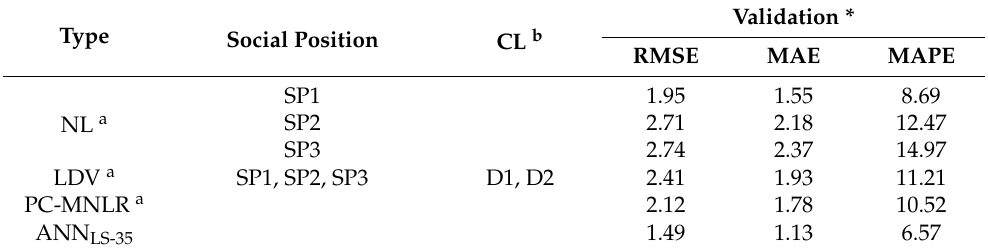
Table 5. Performance of different techniques to estimate the height of Brazilian pine trees.